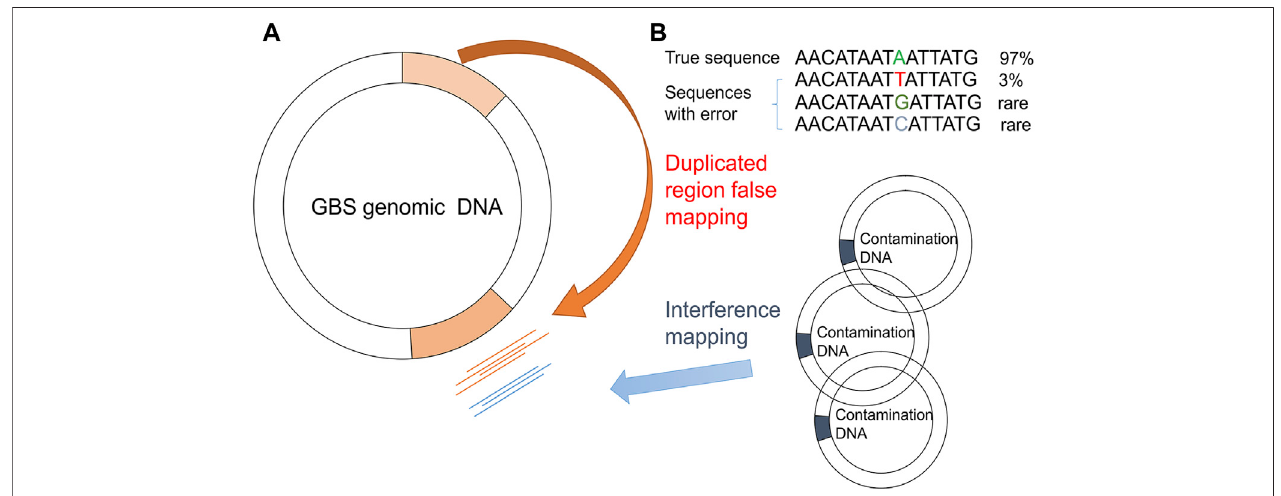
FIGURE 2 | False PM caused by duplicated region/contamination/systematic error (bias). Mapping biases due to GBS genome duplication regions (A) and sequencing errors/contaminated DNA (B) are